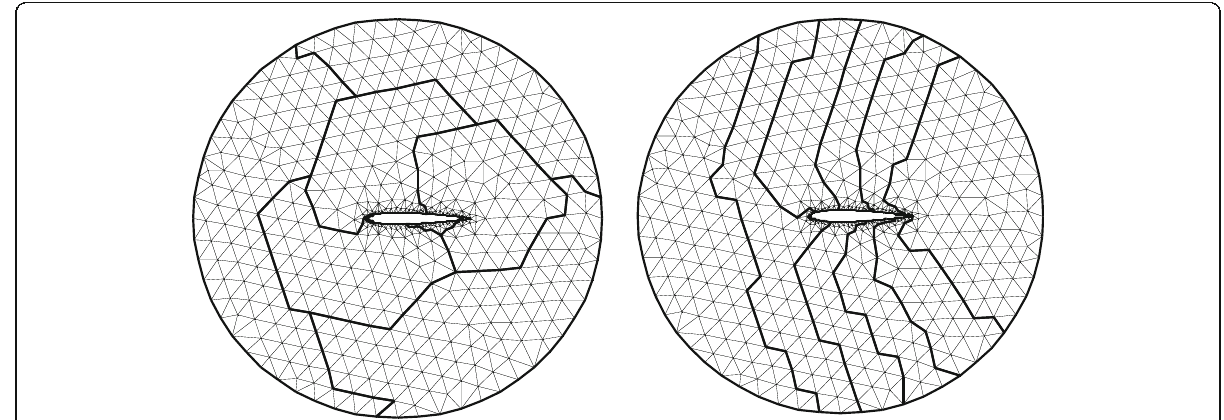
Fig. 3 Meshes using wave-front domain-splitting algorithm